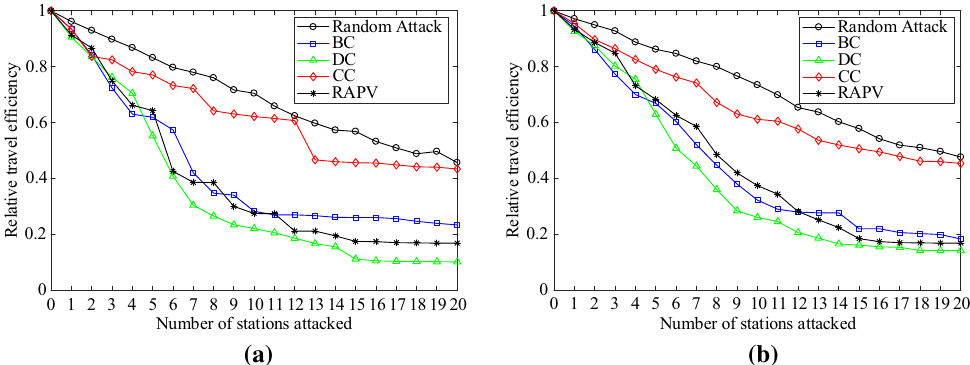
Fig. 3 Simulation output showing relative travel efficiency of the Wuhan subway under five attack modes a during peak hours and b during non- peak